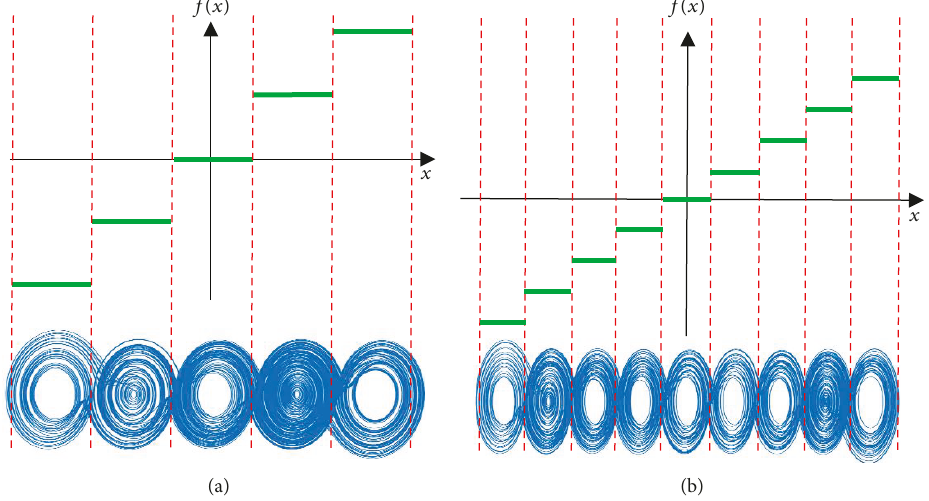
Figure 2: (a) Saturated nonlineal function with n = 5 and its corresponding attractor of fi ve multiscrolls. (b) Saturated nonlineal function with n = 9 and its corresponding attractor of nine